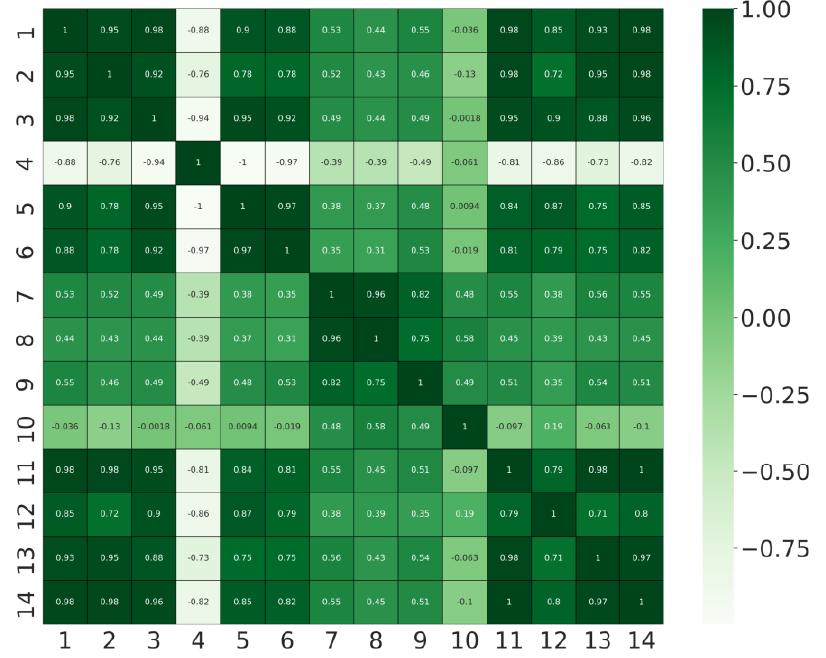
Figure 4. Heatmap of the Pearson correlation results for 14 variables.